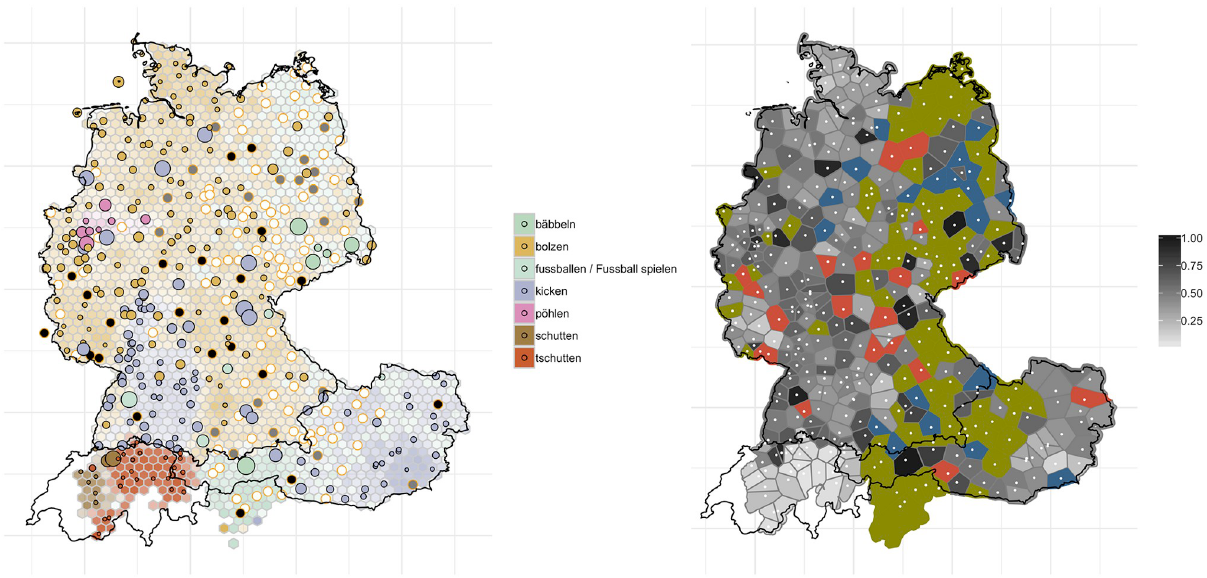
Fig 5. Variant and degree of change maps for ‘non-professional soccer playing’. The left-hand panel shows contemporary data as hexagons with historical data superimposed as dots. The right-hand panel indicates change (black: substantial change, bright grey: very little change).